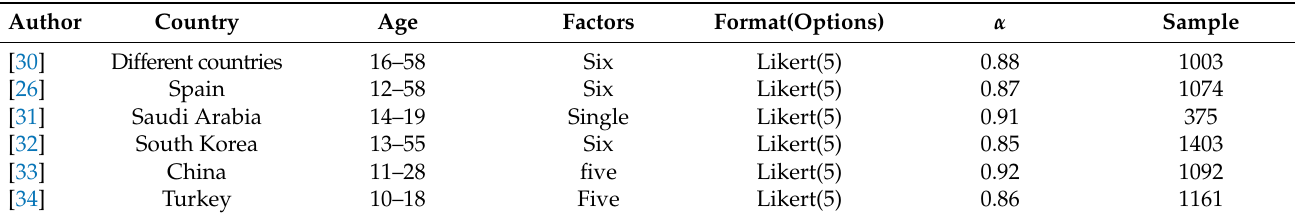
Table 1. Summary of studies about